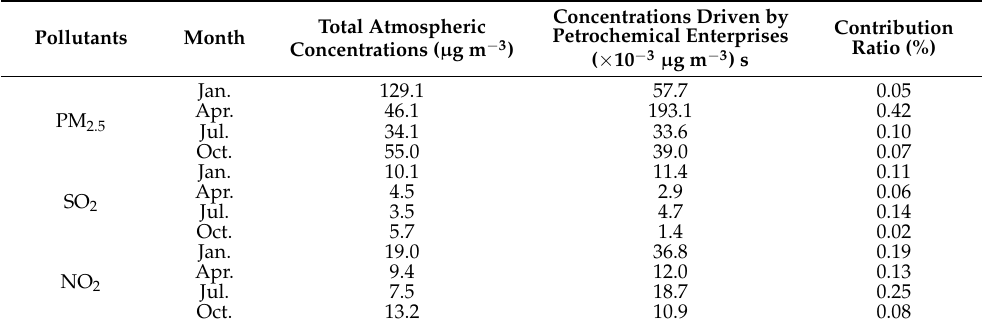
Table 3. Surface concentrations of air pollutants over the NCP region caused by emissions from the four typical petrochemical enterprises and relative contributions to total atmospheric concentrations of the air